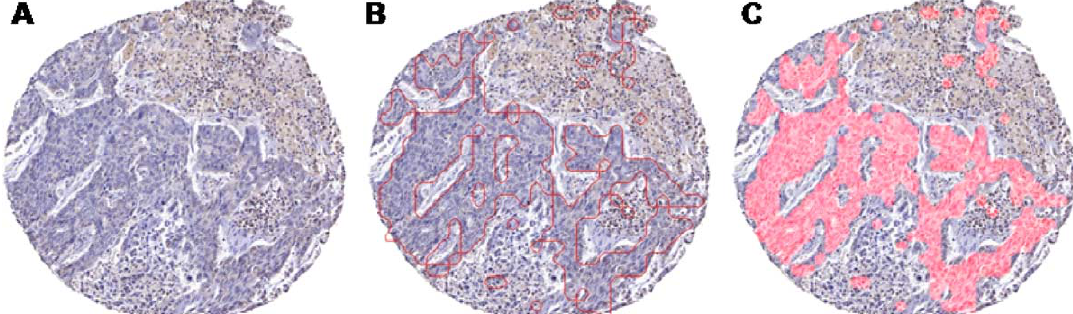
Fig. 6. Examples of tumour region identification using texture feature calculation. Figure A is a TMA core image, Figure B and C marked tumour regions using contour and overlapping pseudo-colour. (Colours are visible in the online version of the article; http://dx.doi.org/ 10.3233/ACP-CLO-2010-0551.)